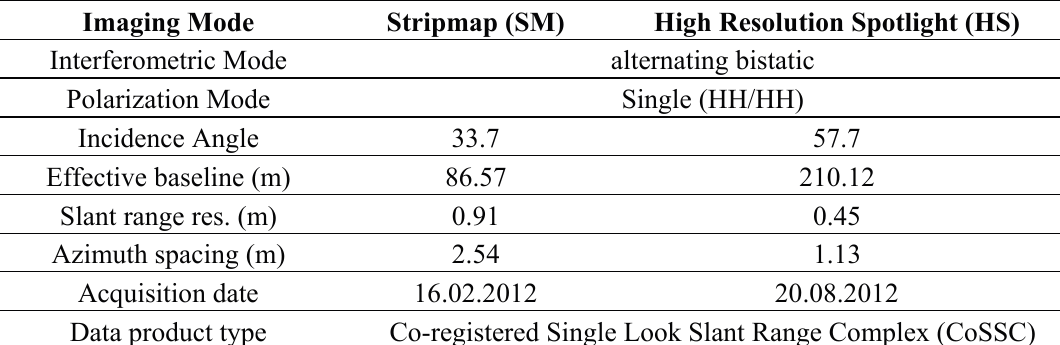
Table 1. Characteristics of available TanDEM-X acquisitions.